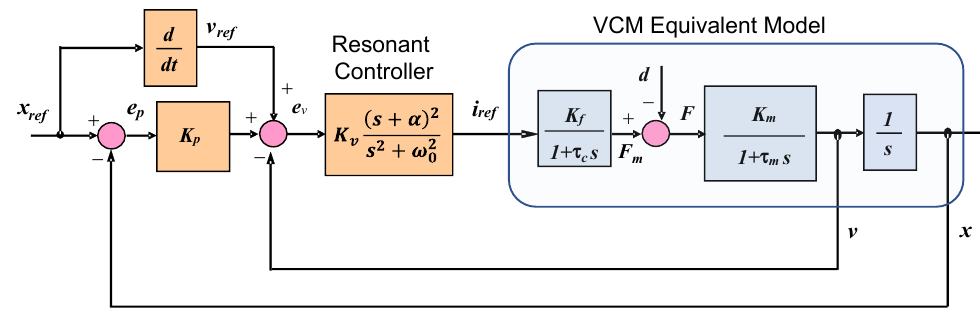
Figure 2. Block diagram of sinusoidal tracking with a resonant-based controller